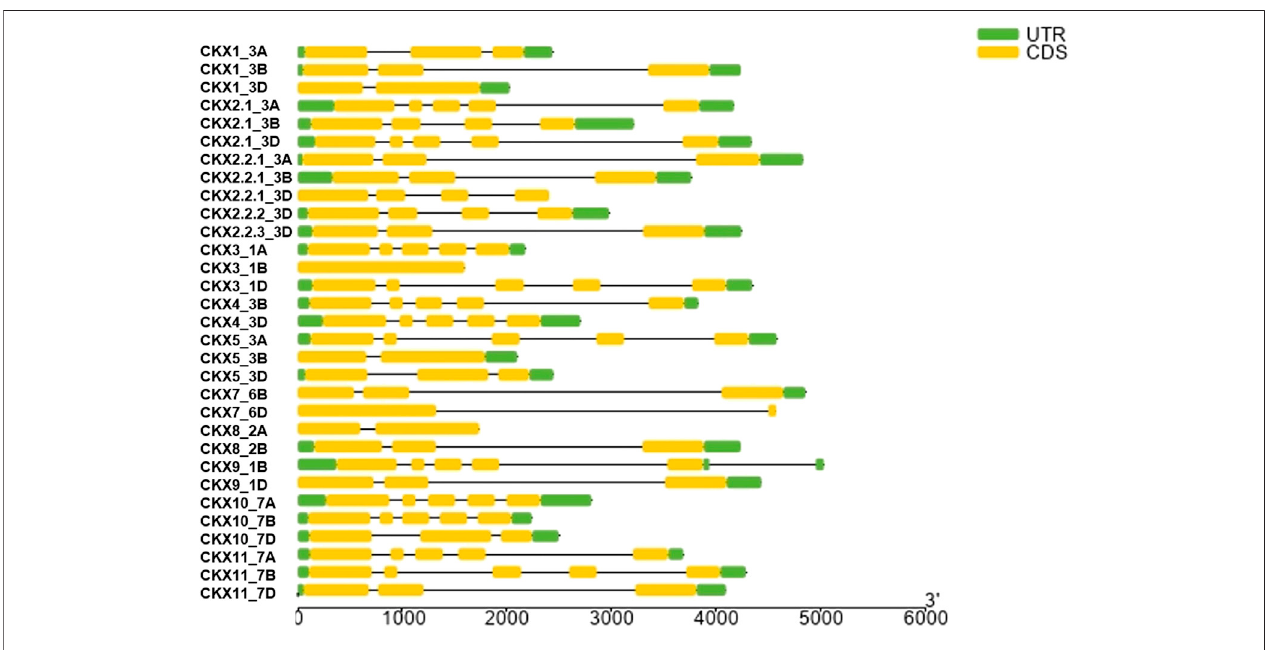
FIGURE 3 | Gene structures of the CKX gene family in Triticum aestivum